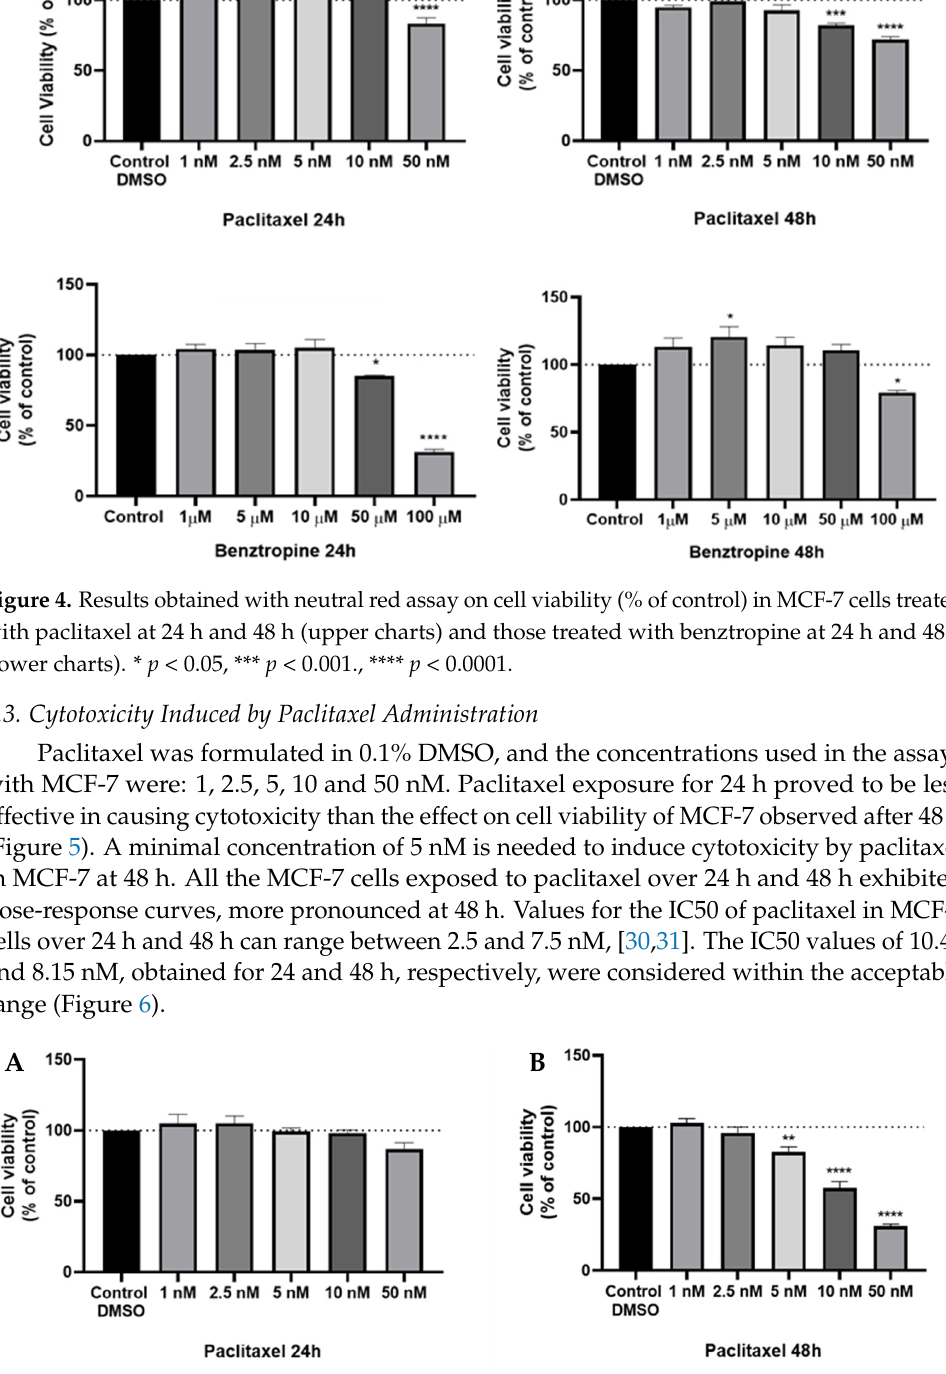
Figure 5. Effect of paclitaxel on the cell viability (% of control) of MCF-7 cells at ( A ) 24 h and ( B ) 48 h of exposure in independent experiments ( n = 4). Results are expressed as mean ± standard error of the mean (SEM). ** p < 0.01, **** p < 0.0001.